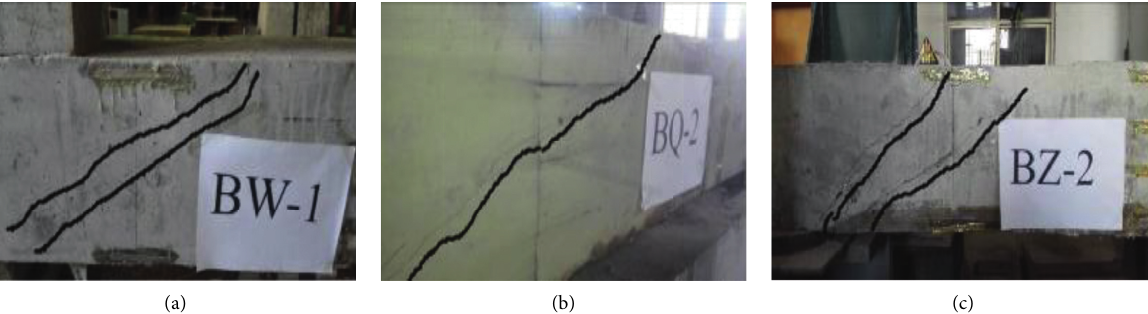
Figure 12: Development of cracks under the fatigue test: (a) BW crack map, (b) BQ crack map, and (c) BZ crack map.